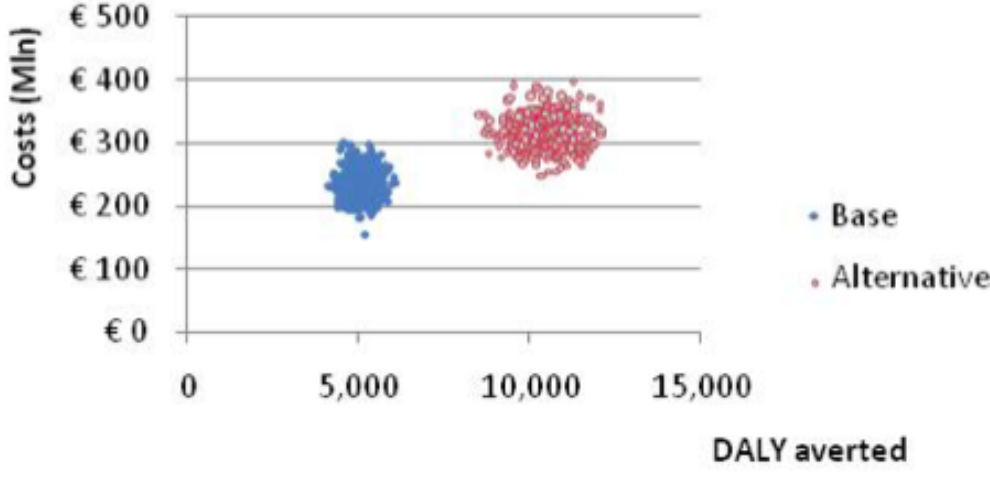
RR (Death)Women, %Men,